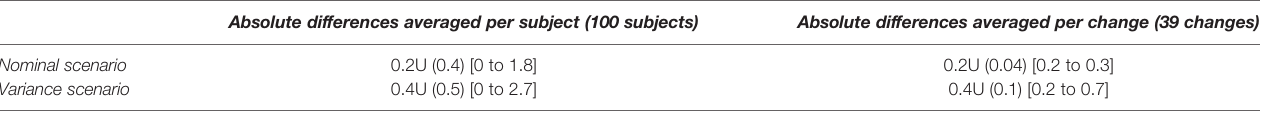
TABLE 3 | Summary of changes between the optimization procedure when the carbohydrate input is reconstructed or counted by virtual subjects. Absolute differences averaged per subject (100